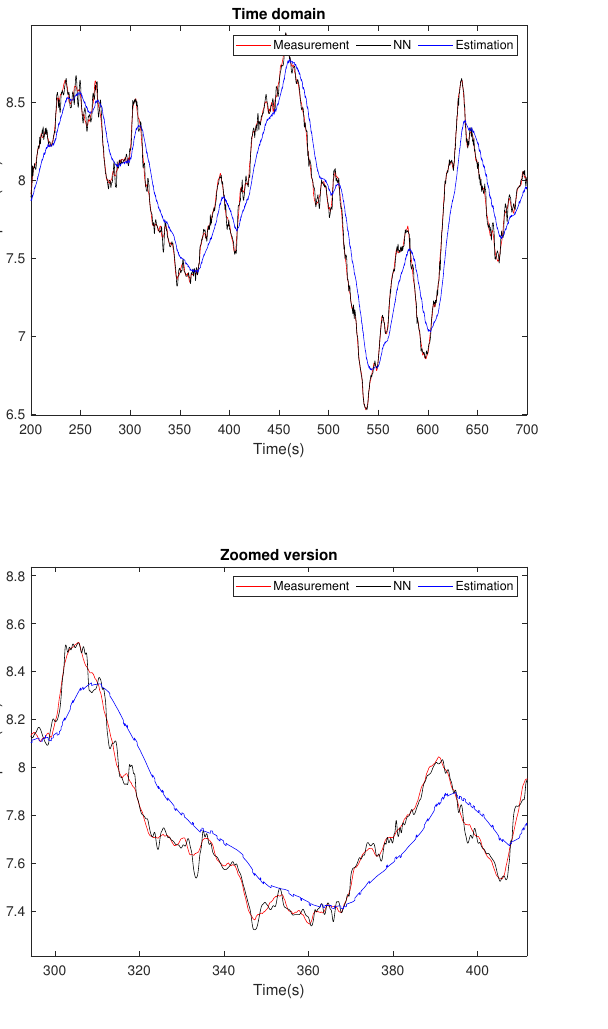
Figure 12. Scenario 4: Wind speed estimation from Turbine